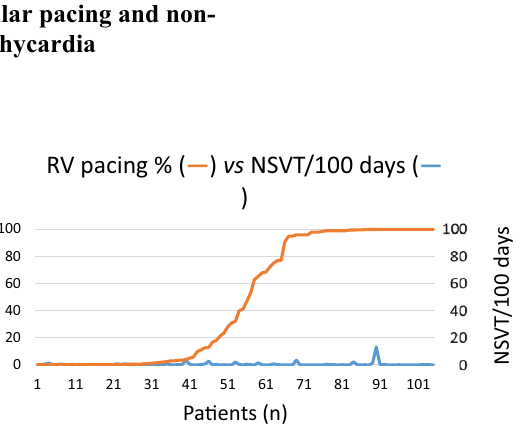
Fig. 1 Relationship between right ventricular pacing and non‑sustained ventricular tachycardia. a Bar graph depicting the relationship between right ventricular pacing (RVP)% ( x axis) and non‑sustained ventricular tachycardia episodes (NSVT)/100 days ( y ‑axis). Note that patients with 100% RVP had significantly less NSVT burden than patients with < 99.9% RVP. b Line graph depicting the relationship between NSVT episodes/100 days (blue line; y ‑axis on the right) and RVP% (orange line; y ‑axis on the left) for all the studied patients ( x ‑axis) aligned from left to right in increasing order of RVP%. Note the increase in NSVT burden (blue line) from left to right as RVP% (orange line) increases, till it reaches 100% RVP when